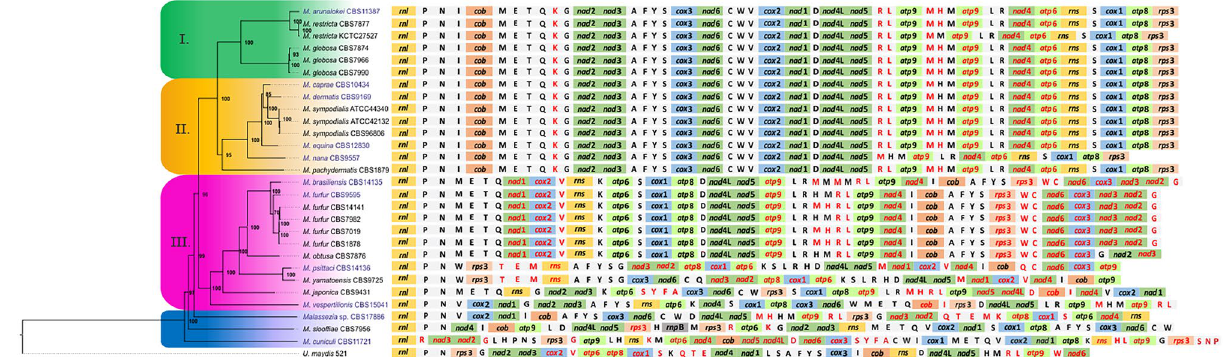
Figure 1. Phylogeny and synteny of the mitogenome of 28 Malassezia strains representing all currently known species. The phylogenetic tree was produced using Bayesian Inference based on the concatenated amino acid matrix of the 15 mitochondrial PCGs. Numbers at the nodes of the tree indicate posterior probability (PP) values. The species Ustilago maydis strain 521 has been used as an outgroup. Shading of phylogenetic clusters is shown as green, yellow, purple, and blue for clades I, II, III and the basal species, respectively. Blue text indicates the taxa whose mt genome is presented for the first time in this study. Additionally, synteny is provided in all cases starting with rnl gene. The genes which are located on the complementary reverse strand are marked with red color. Amino acid symbols represent the corresponding tRNA gene (e.g., P for trn P). Genes referring to